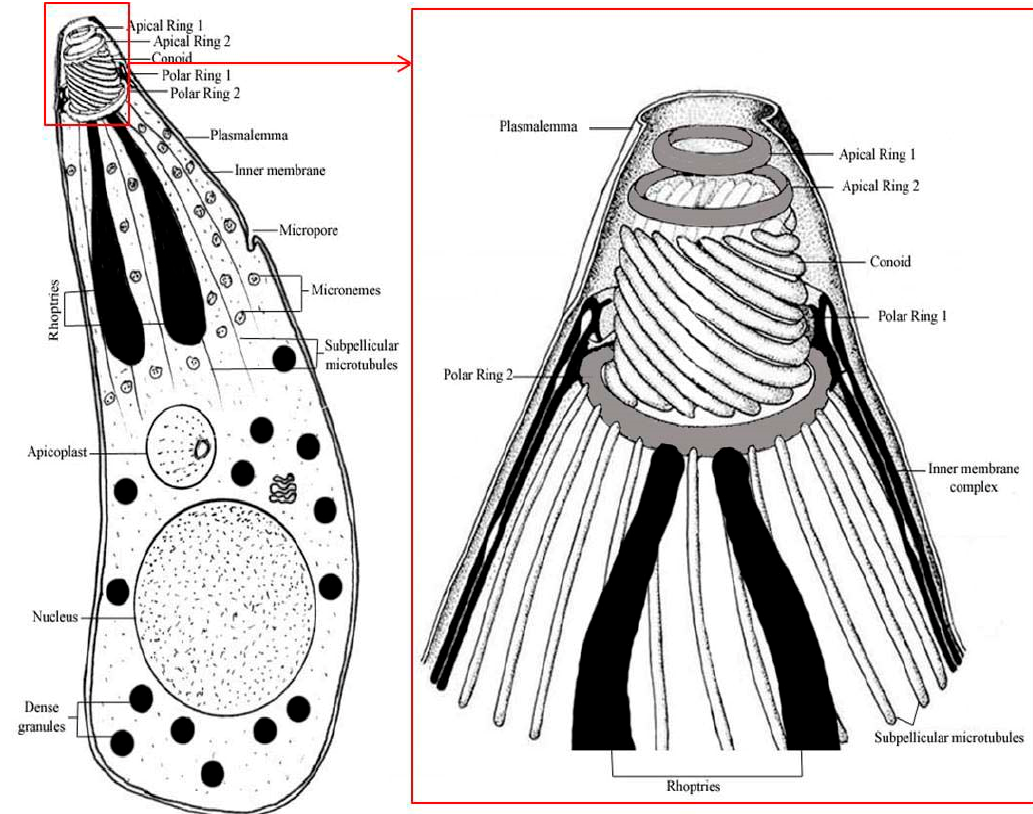
Figure 1. The general structure for the apical complex for Apicomplexa.